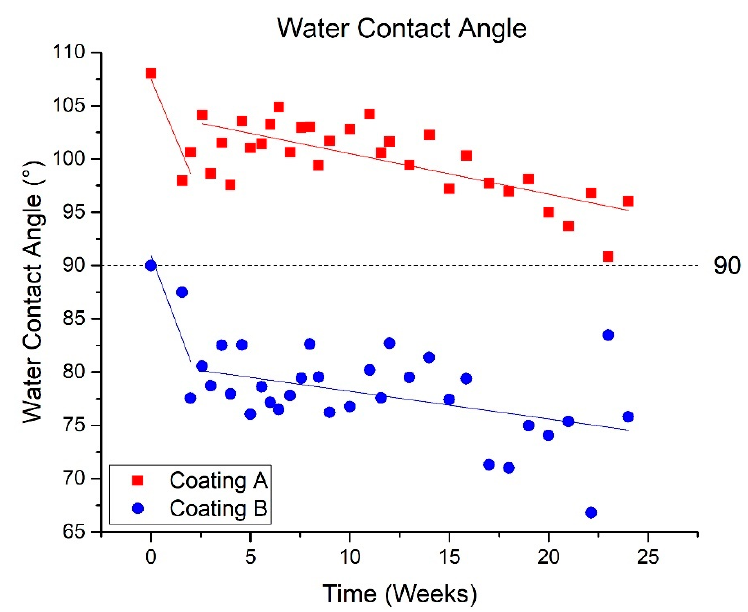
Figure 8. Water contact angle measurements for coated coupons over time. Trendlines are shown as solid lines with corresponding colours. Values above the black dashed line are hydrophobic (>90°) and below this line are hydrophilic (<90°).